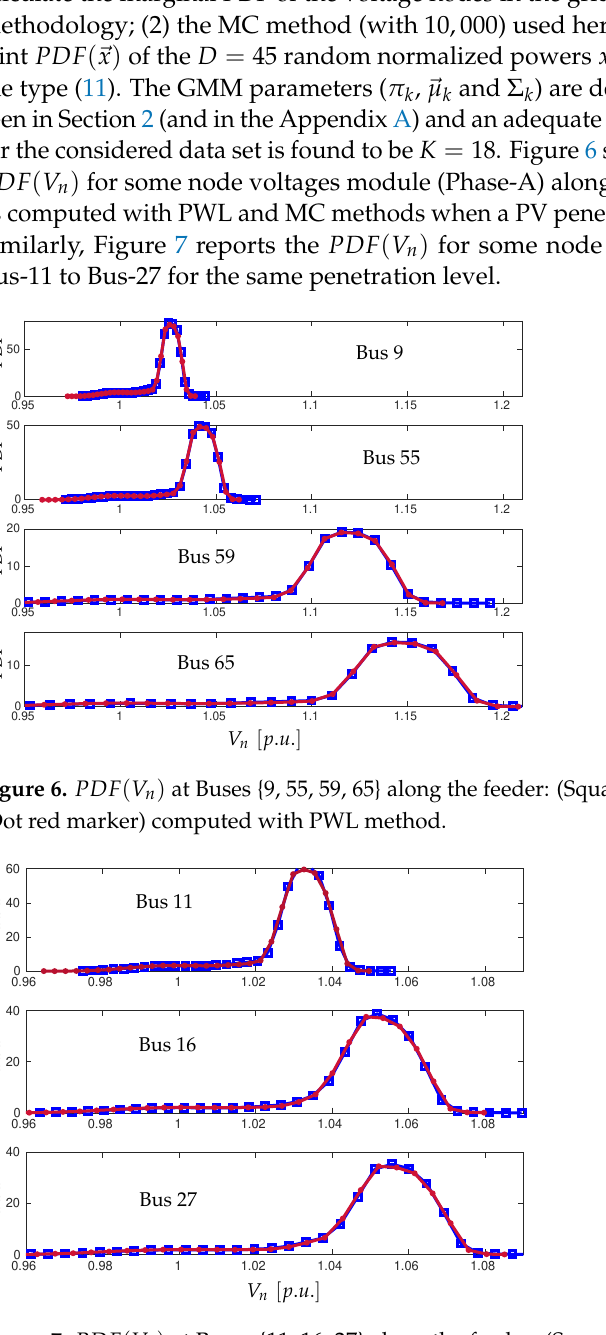
Figure 7. PDF ( V n ) at Buses {11, 16, 27} along the feeder: (Square blue marker) computed with MC; (Dot red marker) computed with PWL method.